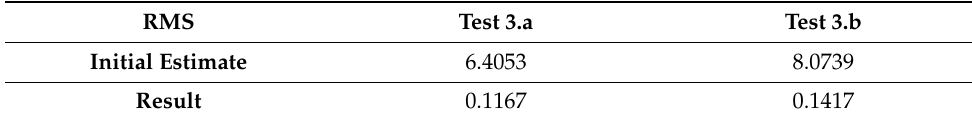
Table 4. The change of RMS in test